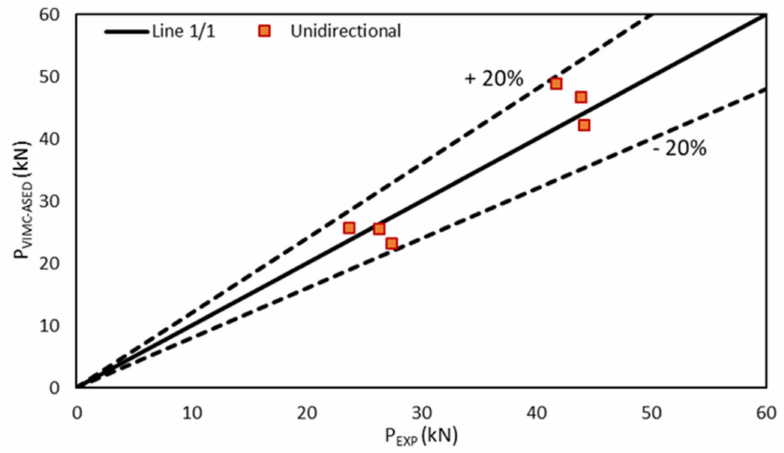
Figure 5. Comparison between the critical load prediction and experimental results in unidirectional specimens (0).